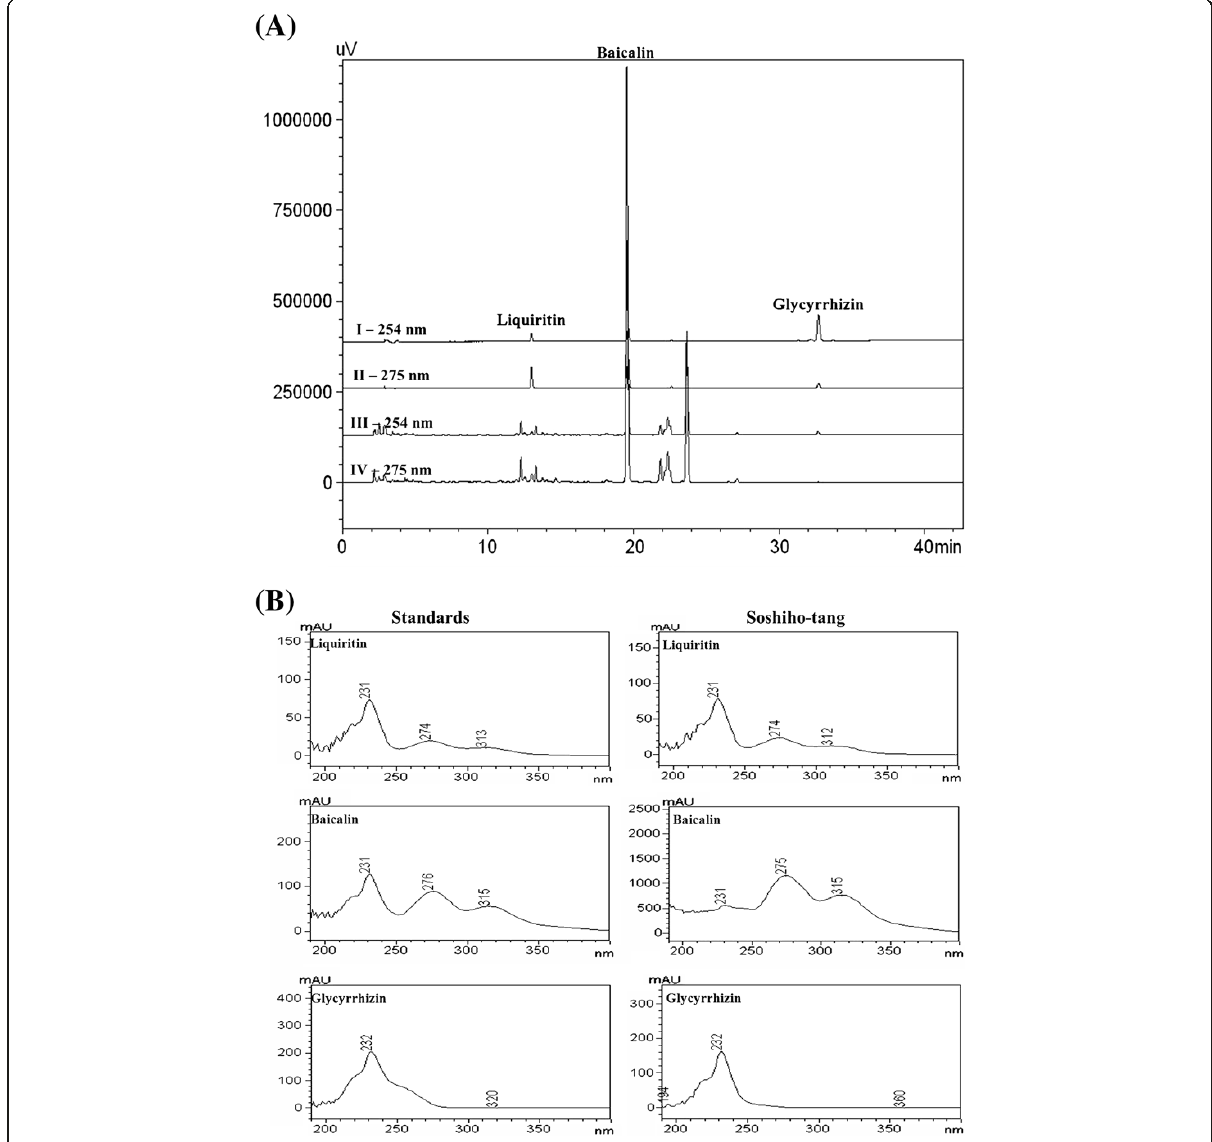
Figure 2 HPLC chromatogram of the standard mixture and SST with PDA detector (A) and UV – vis absorption spectra of compounds